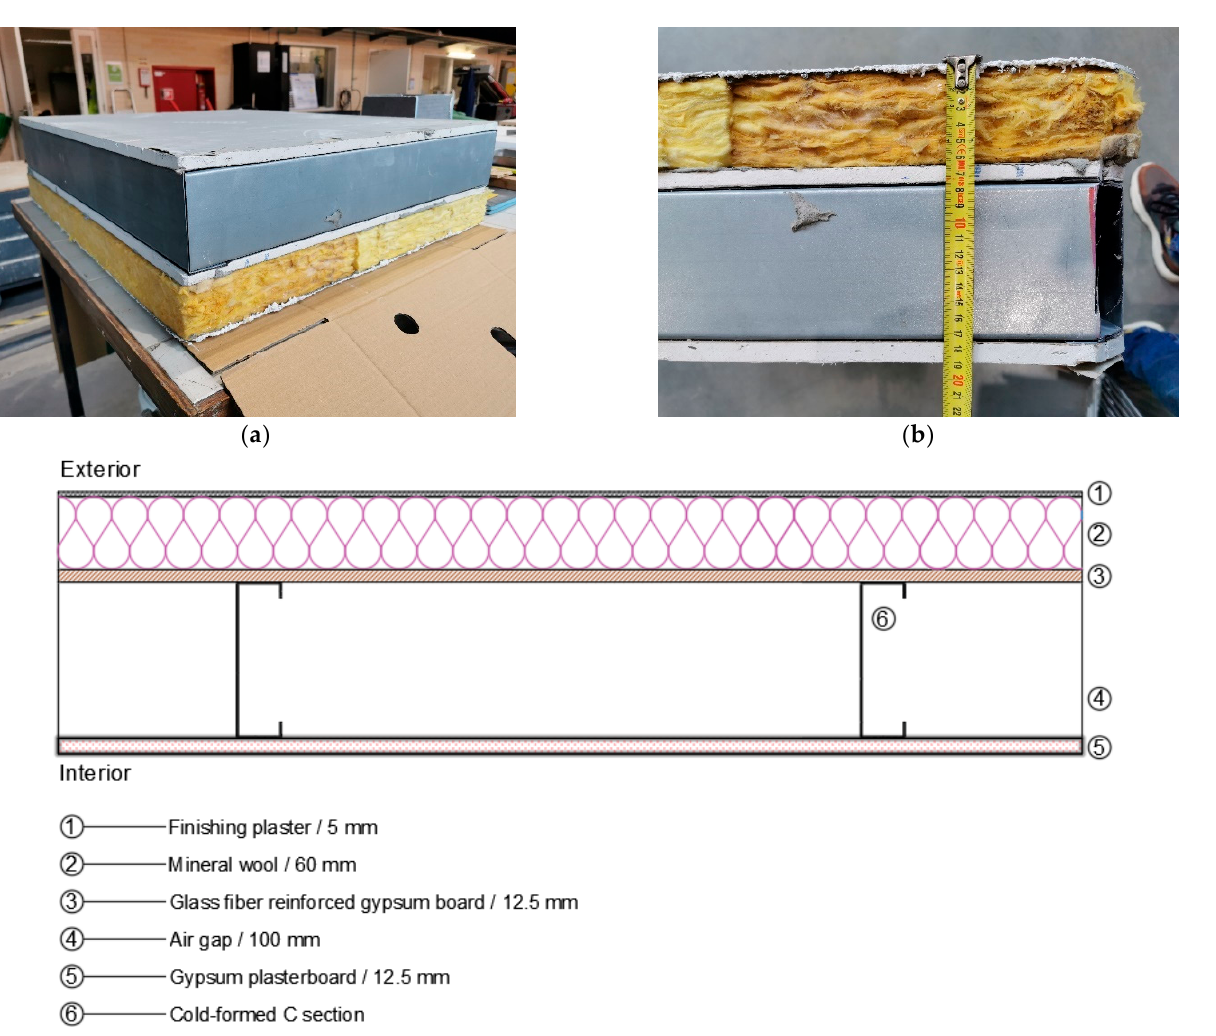
Figure 3. Construction solution of the envelope walls: ( a ) 3D view of wall component; ( b ) cross section view of the wall component; ( c ) layered composition of the reference solution.